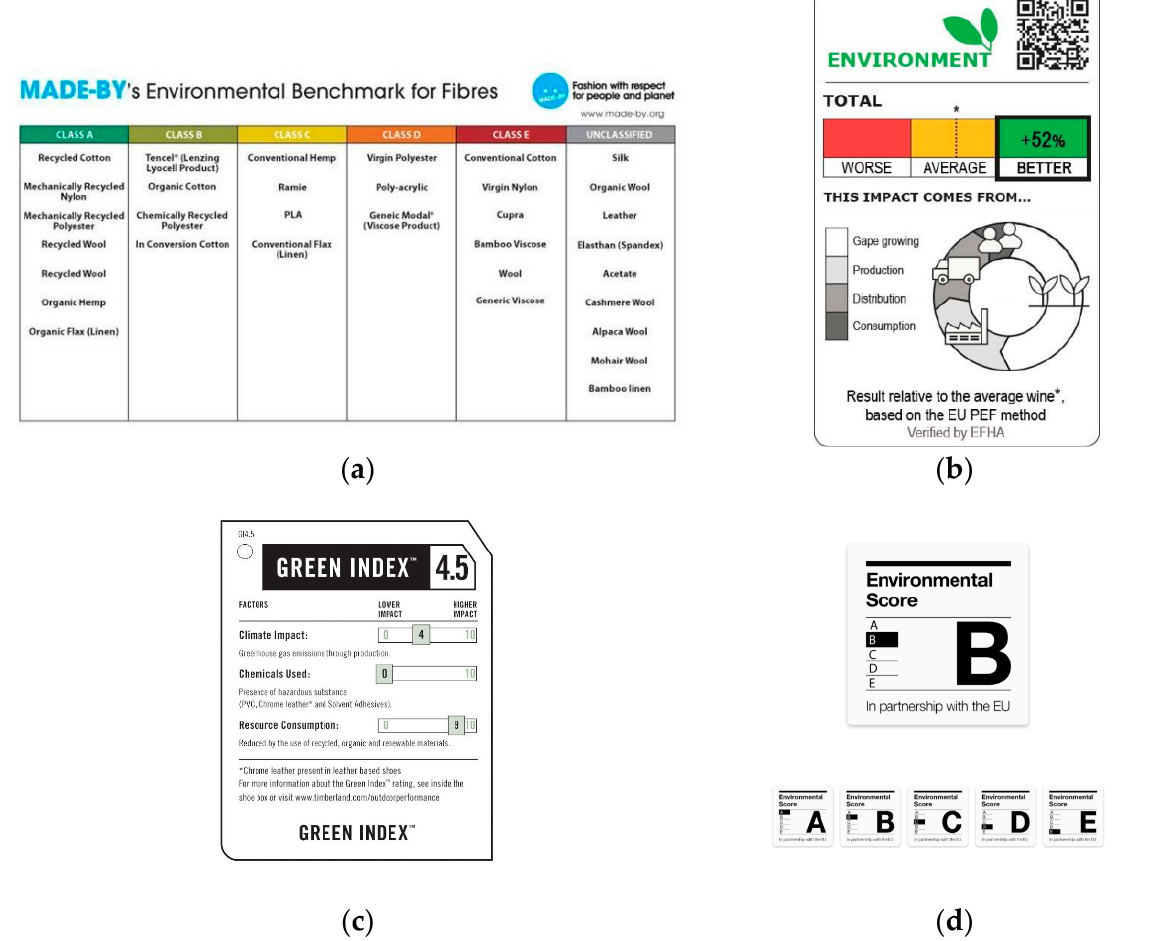
Figure 9. Examples of communication of sustainability benchmarks/labels [15,16]. ( a ) Class A to E—available data to score; Class F—data not yet available to score. Considers only cradle-to-yarn LCA regarding greenhouse gas emissions; human toxicity; eco-toxicity; energy; water; and land (recycled wool has the highest possible “A” scorecard rating whereas, controversially, virgin wool has the lowest rated “E” score.) [19]. ( b ) Overall PEF performance on a three-level scale, percentage relative to the average, and percentage contribution of life cycle stages to the total [20]. ( c ) Score 0 (lowest impact) to 10 (highest impact) in climate impact (kg CO 2eq for shoes/10); chemicals (0 uses = 0, 1 = 2.5, 2 = 5, 3 = 7.5, 4 = 10); resources (weight of non-recycled, organic, or renwable material/weight of shoe)*10. ( d ) Weights used for normalized impact categories are 22.19% for climate change; 9.54 for particle matter; 9.03 for water use; 8.92 for resource use, fossils; 8.42 for land use; 8.08 for resource use, minerals and metals; 6.75 for ozone depletion; 6.64 for acidification; 5.37 for ionizing radiation; 5.10 for photochemical ozone formation; 3.91 for eutrophication, terrestrial; 3.12 for eutrophication, marine; 2.95 for eutrophication,